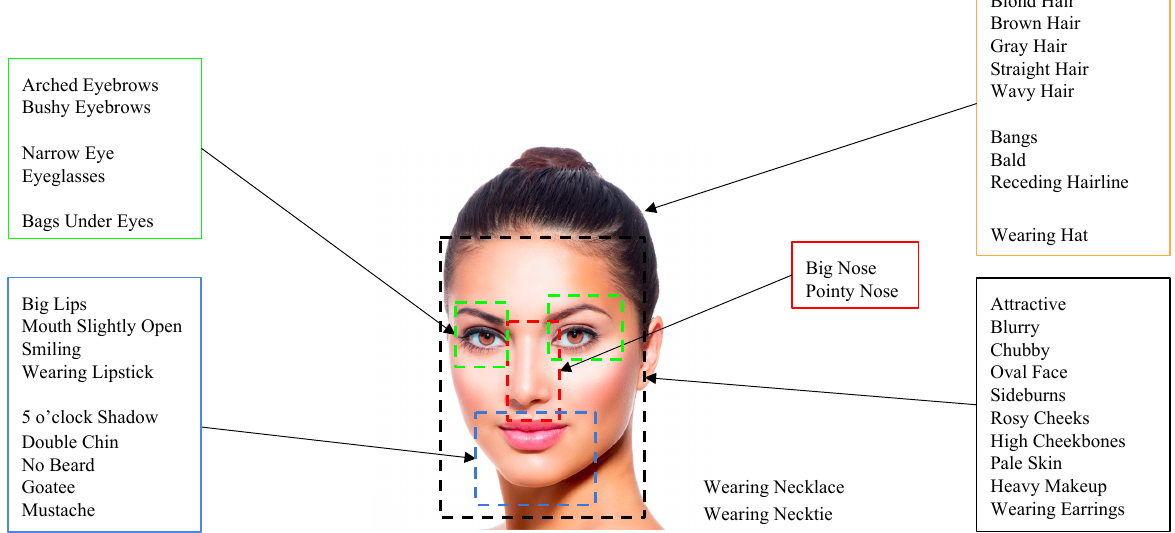
Figure 5. A graphical representation of the 40 attributes used to describe